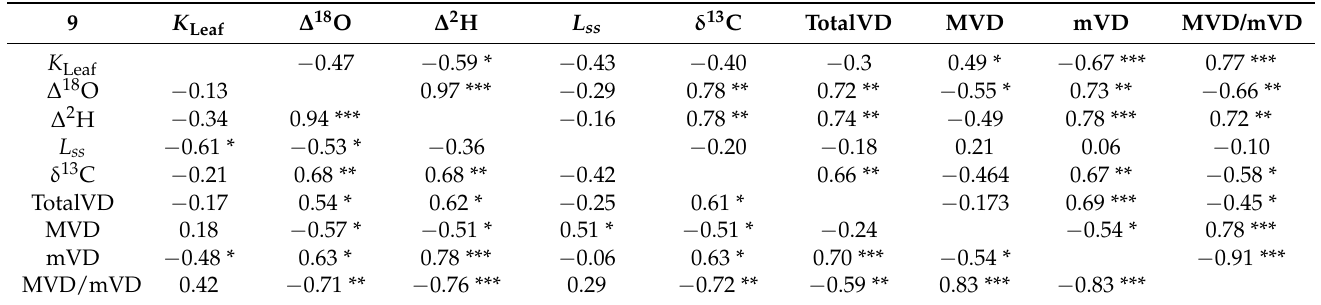
Table 1. Correlation analysis of leaf hydraulics, isotopes and venation traits in the three species here studied. Upper triangle corresponds to result of Pearson correlation; lower triangle corresponds